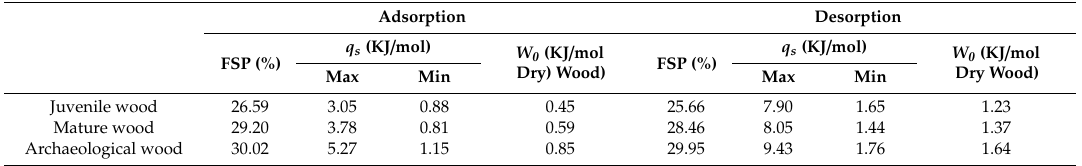
Table 4. Thermodynamic parameters of juvenile, mature, and archaeological wood. FSP (%) is the fiber saturation point; q s is the net isosteric heat of sorption; W 0 is the total heat of wetting. Adsorption Desorption